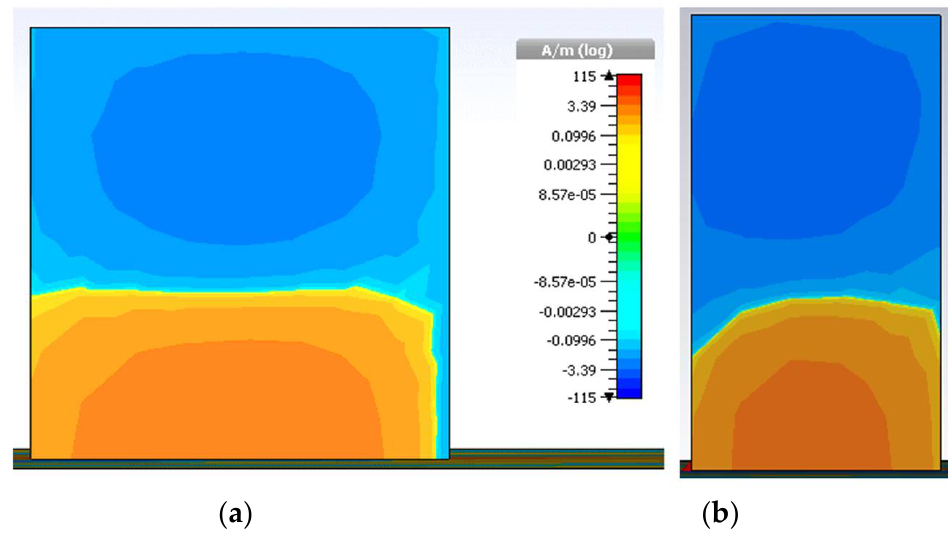
Figure 9. Distribution of magnetic field ( a ) TE xδ13 at 3.72 GHz and ( b ) TE y1δ3 at 4.35 GHz.